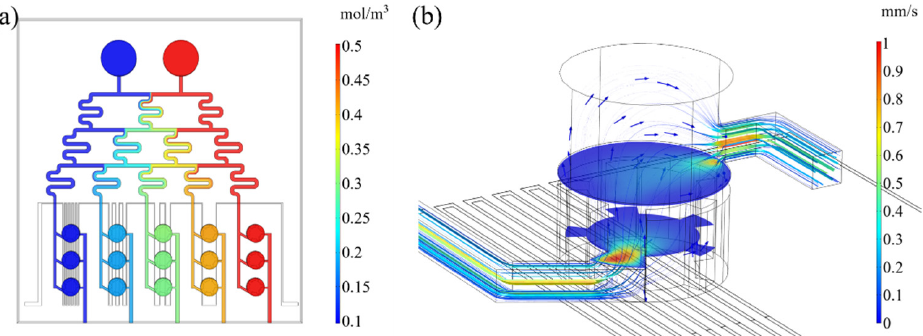
Figure 3. Flow field distribution diagram in the microchannel. ( a ) Concentration distribution map in microchannel under steady state. The values of the concentrations are shown in the legend on the right. ( b ) Streamline distribution of the flow field in a culture chamber. The values of the flow rate are shown in the legend on the right, and the shear rates are represented in terms of the thickness of the flow lines.